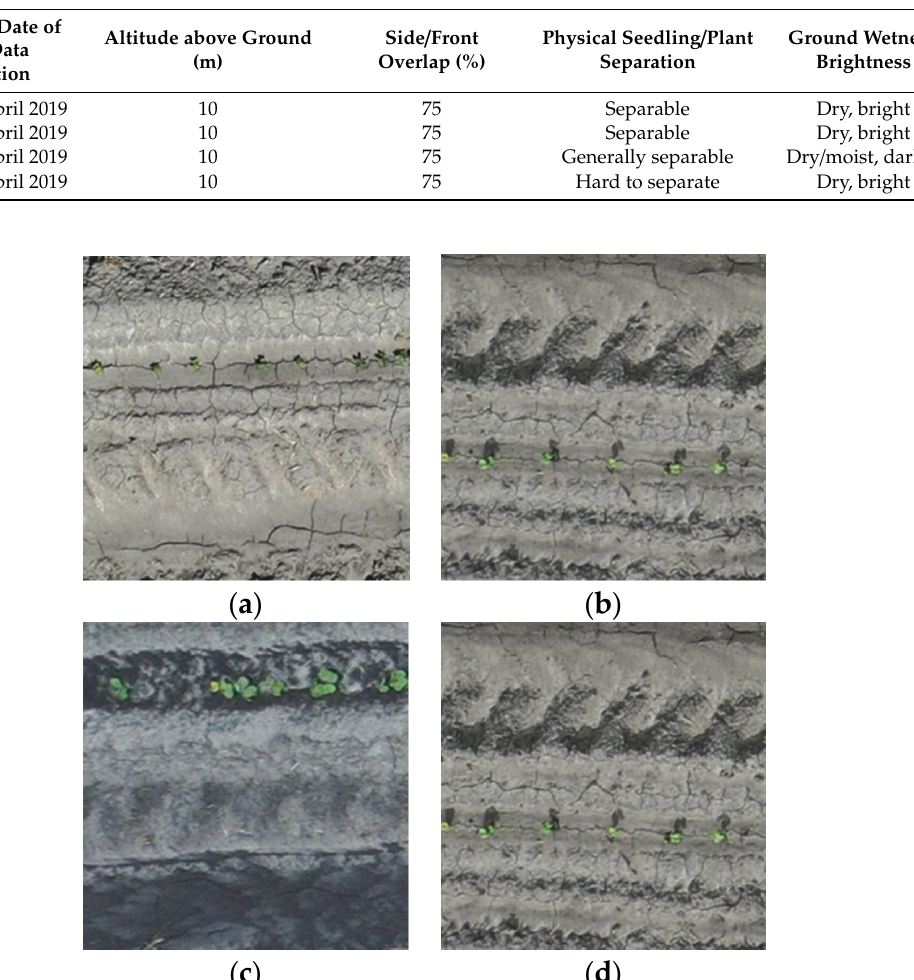
Table 1. Summary of Unmanned Aircraft Systems (UAS) data collection.